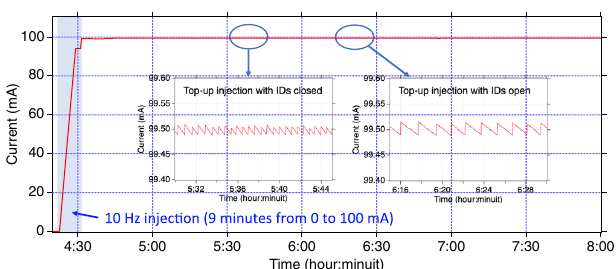
FIG. 4. Stored current of the SPring-8 storage ring during the beam injection. The electron beam is injected from SACLA at 10 Hz from 0 mA and the current is maintained at 100 mA with the top-up injection. Insets show the stored current during the top-up